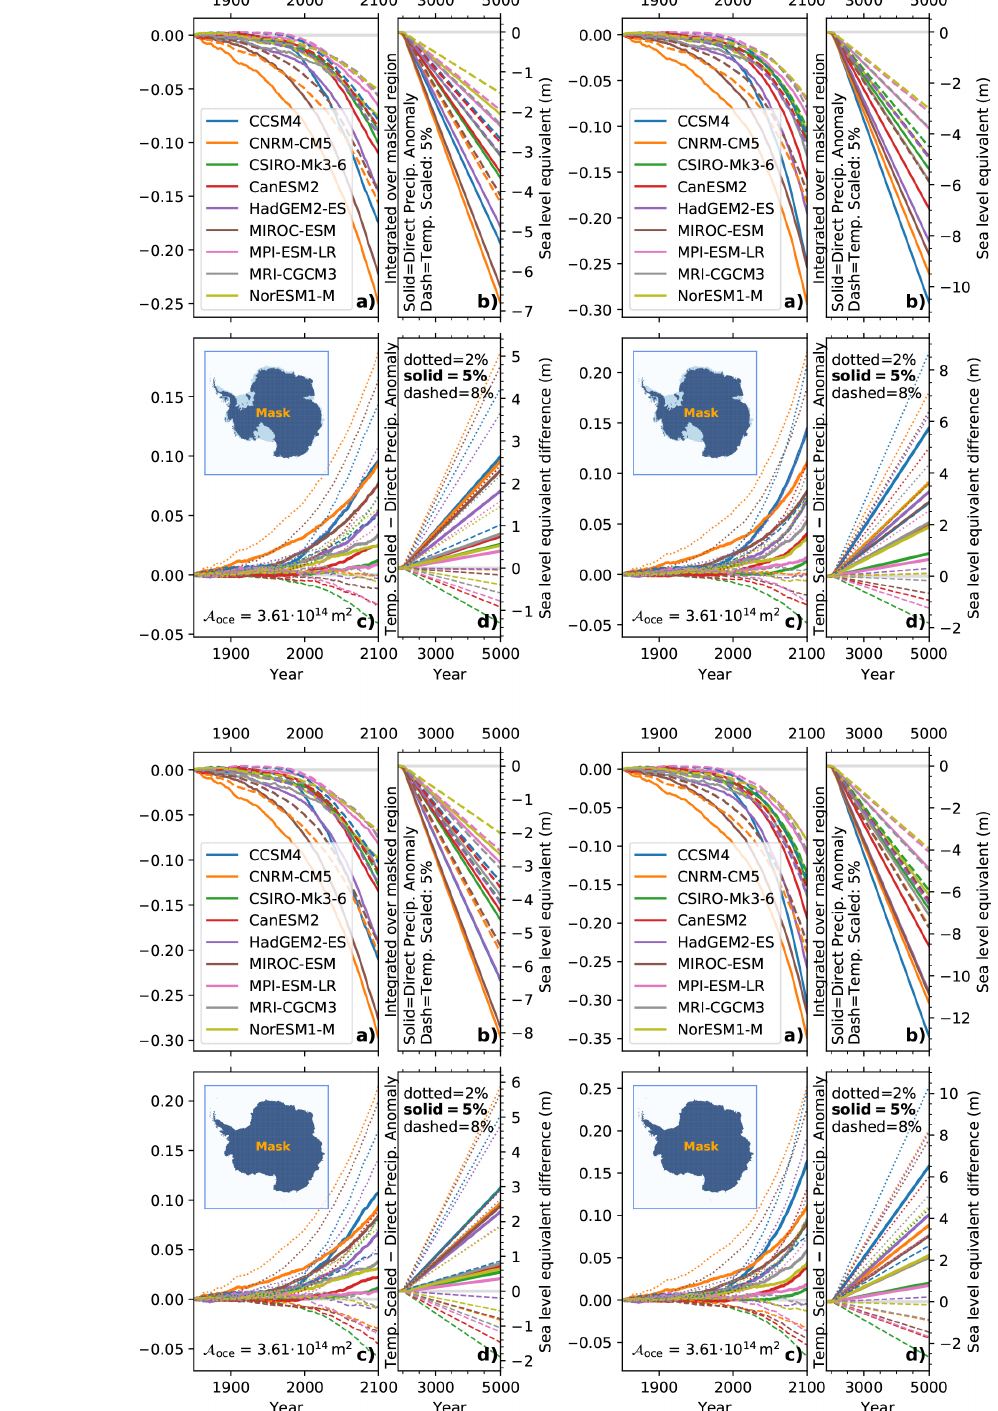
Figure E4. Integrated potential sea level equivalent of the precipitation falling on Antarctica (see the inset mask in each subpanel) from the anomaly forcing ( a, b : solid lines) and temperature-scaled precipitation ( a, b : dashed lines). The potential sea level impact between the anomalies and the temperature-scaled precipitation (c, d) is depicted for each CMIP5 model. The left and right columns show the results under the RCP4.5 and RCP8.5 scenarios, respectively. The upper row depicts the scaling for the entire Antarctic continent (“glaciered”), whereas the lower row is restricted to grounded ice. The lower left set of subpanels is identical to Fig. 6. The reader is referred to Fig. 6 for further details. The grounded and floating ice areas are derived from Fretwell et al.